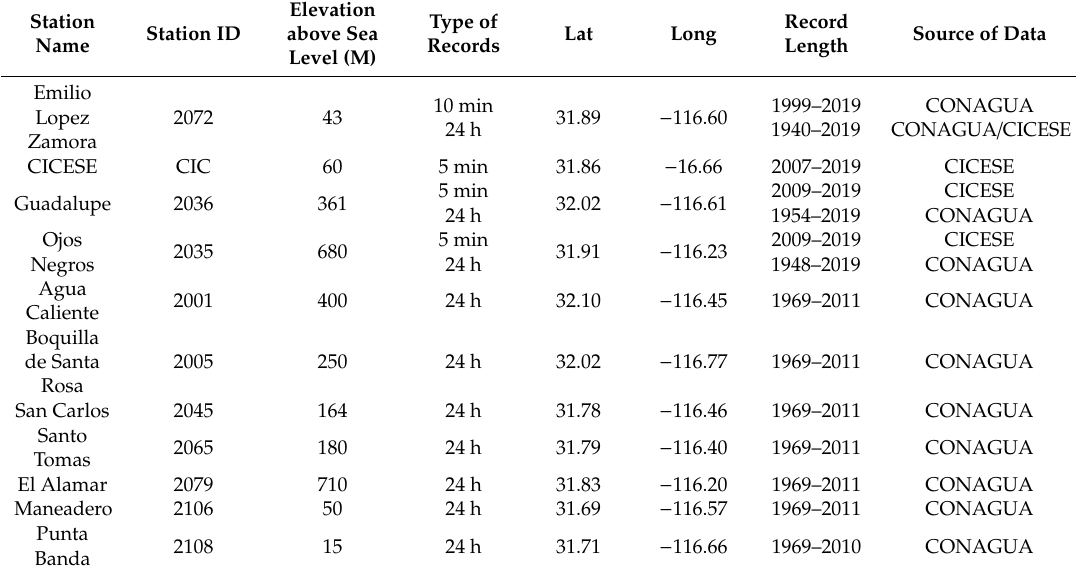
Table 1. Rain gauge network from the study zone.